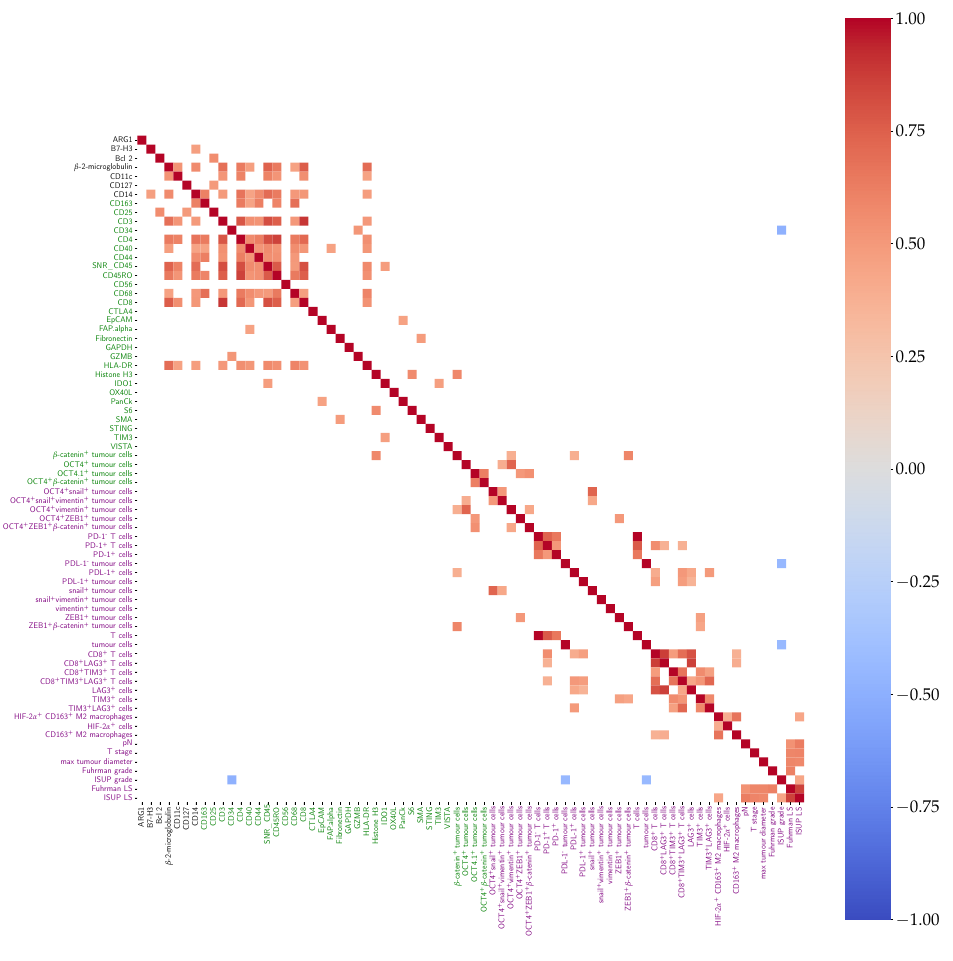
Figure 5. Heatmap showing positive (red), negative (blue), or no (white) correlation among molecular markers assessed with DSP (black), IF (green), and morphological (purple) features, aggregating the TMA core replicates by mean per patient. Only correlations with p < 0.05 after Chow–Denning correction are shown.